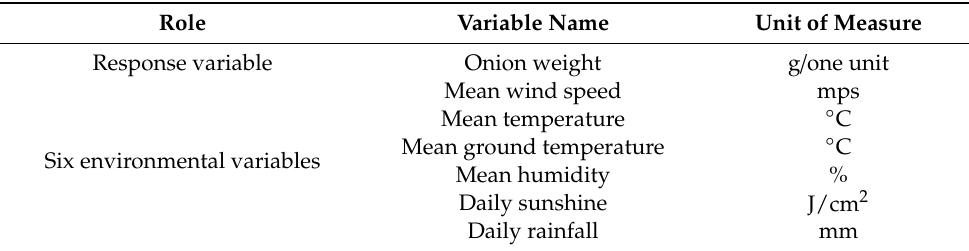
Table 1. The response variable and environmental variables used in data set.